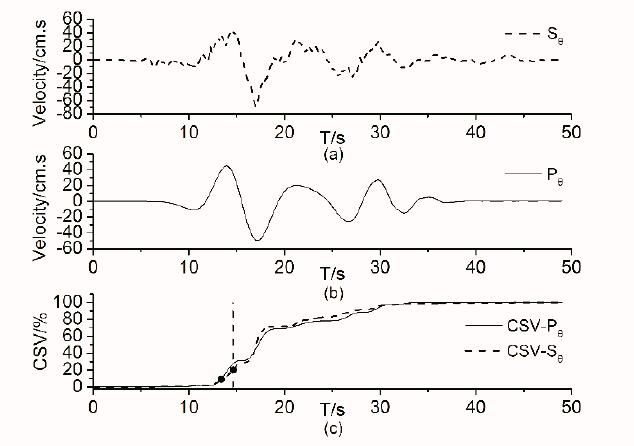
Figure 8. The early arrival of pulse energy by the CSV curves for the signals at station TCU101, ( a ) S (cid:2968) , ( b ) P (cid:2968) , and ( c ) CSV curves for signal S (cid:2968) and P (cid:2968) .